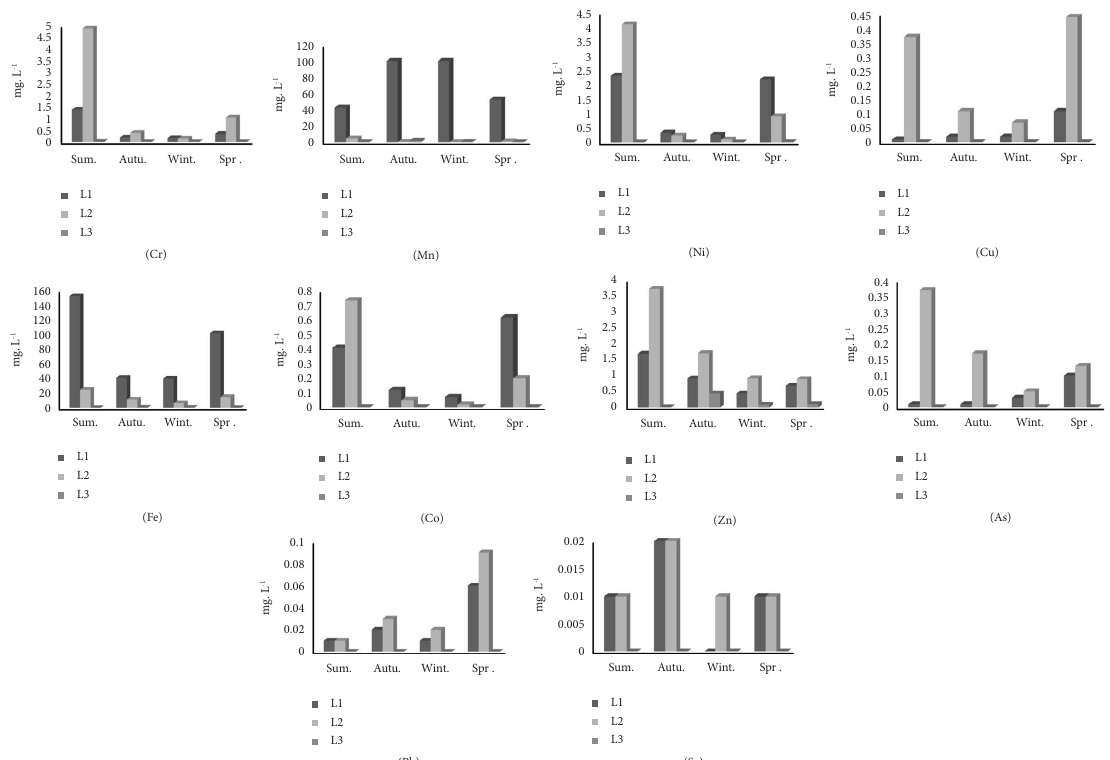
Figure 2: Heavy metals (Cr, Mn, Ni, Cu, Fe, Co, Zn, As, Pb, and Se) of three leachate samples were collected from the dumping during four seasons the year